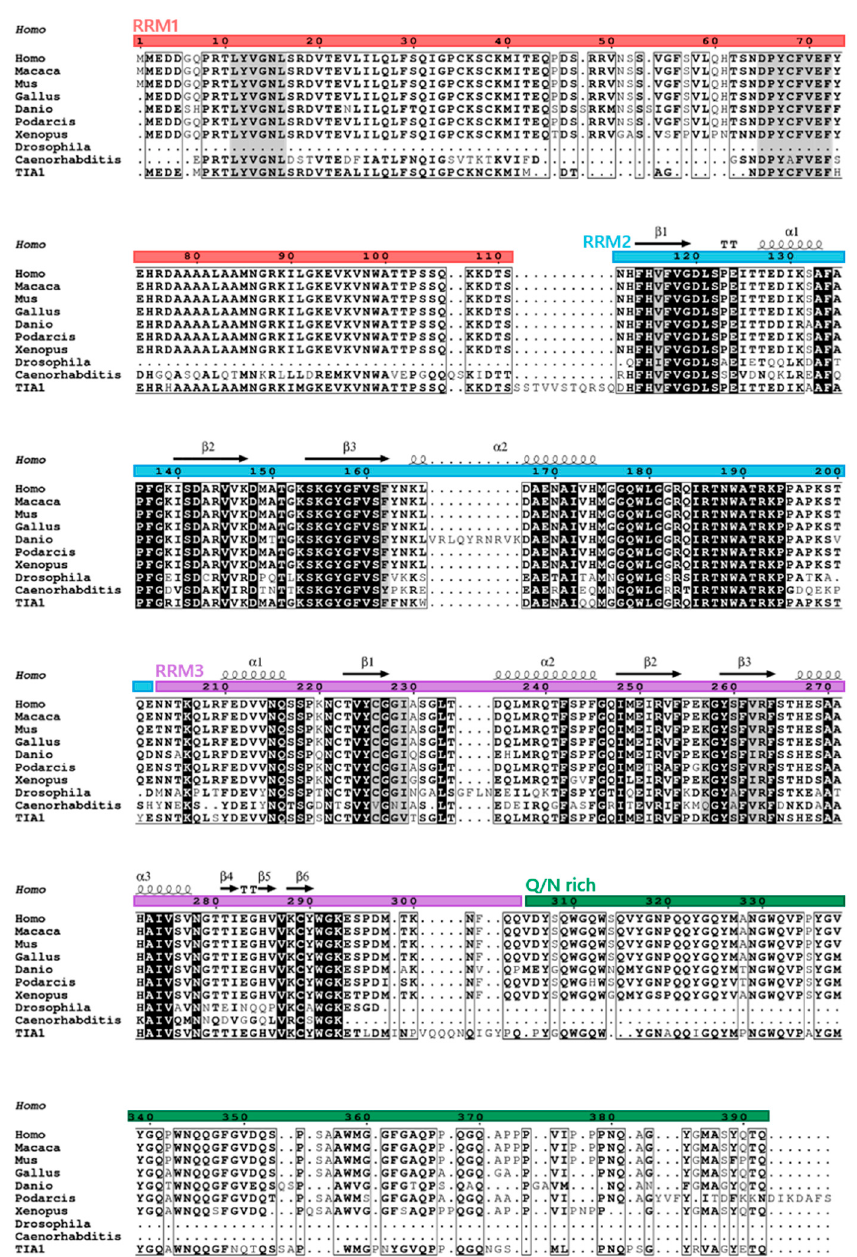
Figure 3. High degree of conservation of TIAR orthologs. Alignments of TIARs from different species as well as human TIA1 are shown. Primary sequences of amino acids used in the analysis are as follows: Homo sapiens (Human) TIAR, PI_AAA36384.1; Macaca mulatta (Rhesus monkey) TIAR,